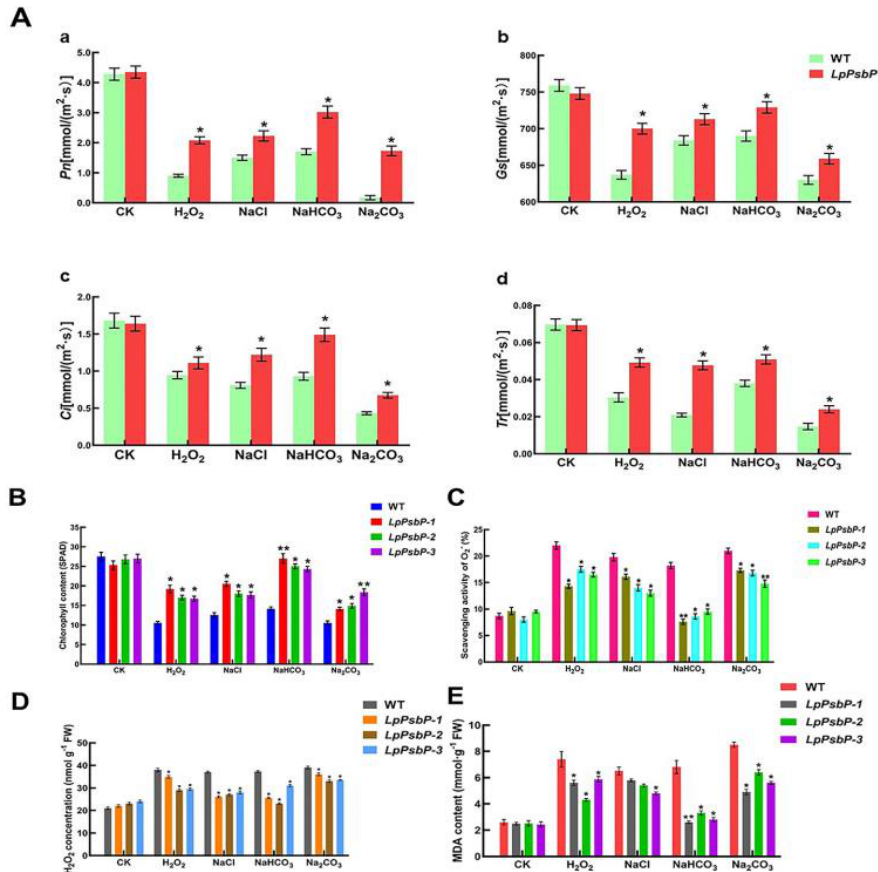
Figure 5. Analysis of physiological indices of tobacco under Saline-Alkali stress. “*”